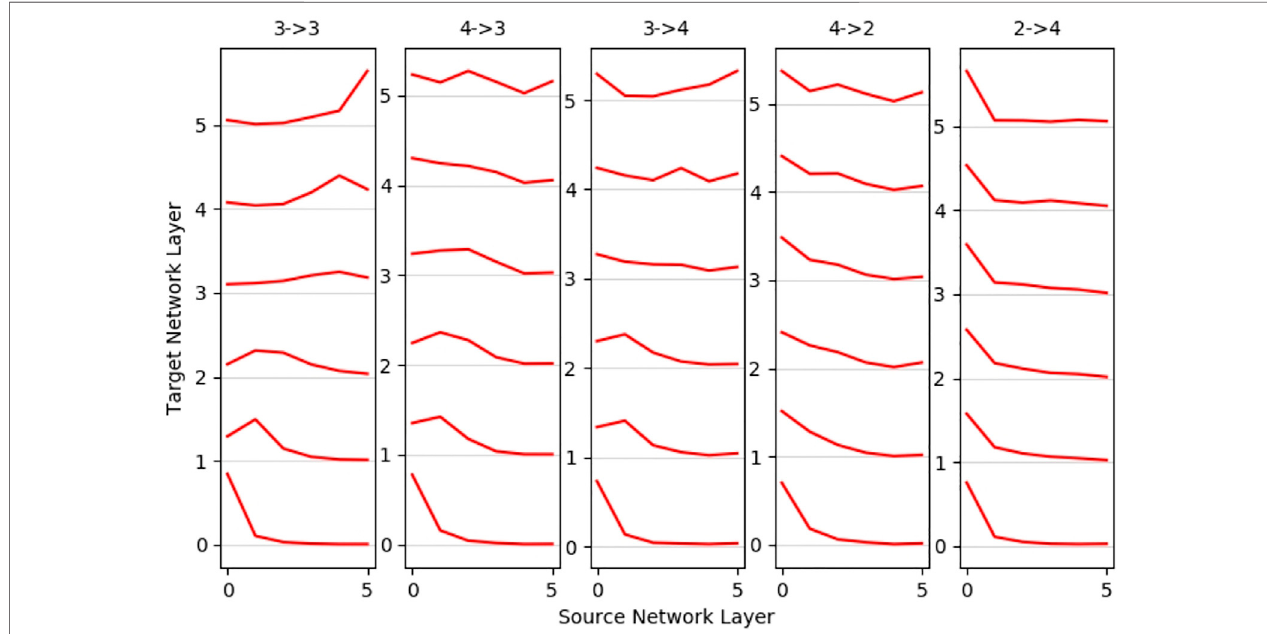
FIGURE 7 | Mean layer-to-layer projections: networks trained for robots with similar degrees of freedom show better layer-to-layer mappings. The fi rst layer of the source network shows high utilization for mappings toall other layers, and the penultimate layeris themost unlikely tobe utilized. The middle layer maps reasonably well for 4-3 and 3-4 mappings, and more distinct robots as 4-2 and strongest in 2-4 mostly utilize fi rst layer neurons only.